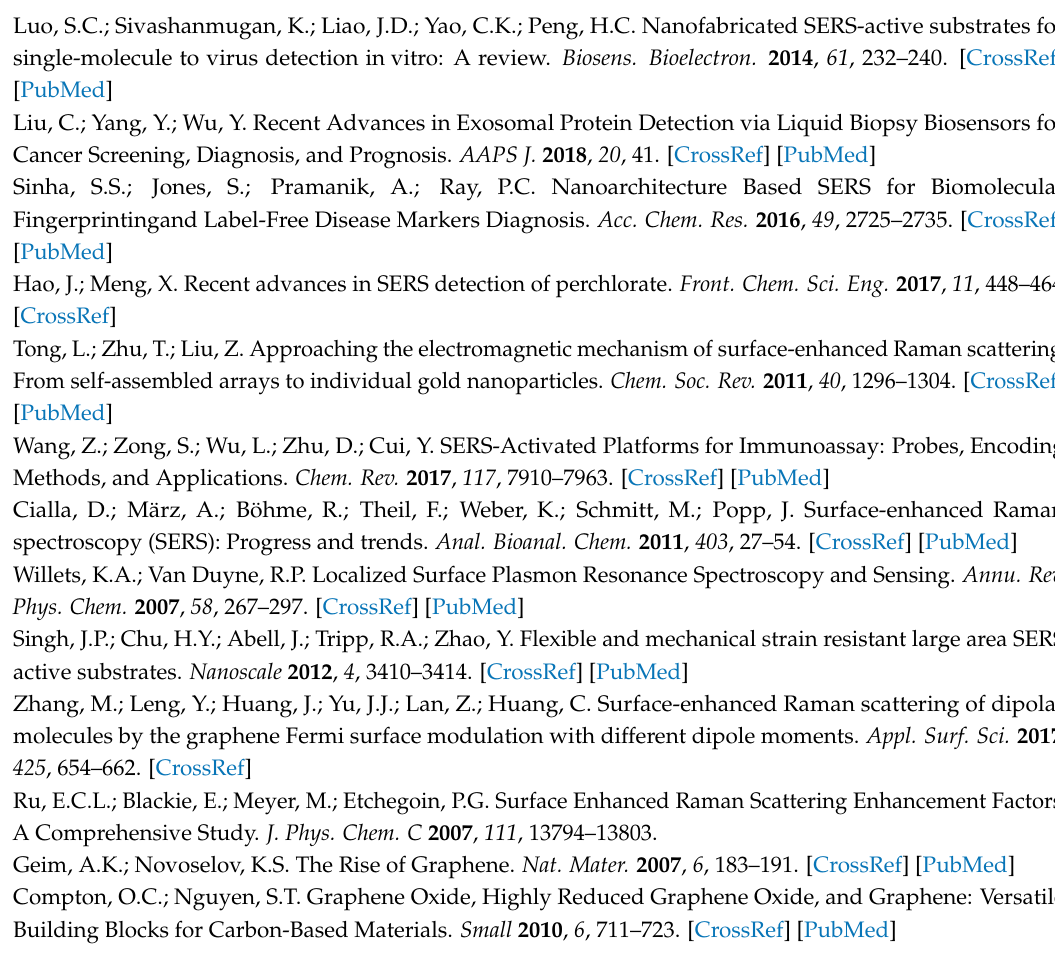
s1, Figure S1: Raman spectra of R6G (10 − 3 M), CV (10 − 3 M), and MG (10 − 3 M) on glass slide substrate, Figure S2: Raman spectra of R6G molecules deposited on GO-LN films by immersing in the solution with different concentrations, Table S1: Sheet resistance of as-prepared samples characterized using four-probe resistance tester, Table S2: Raman peak positions (in cm − 1 ) of R6G, CV and MG on glass slide substrate, and the relative spectral shifts and the enhancement factor (EF) values of R6G, CV and MG on the surfaces of different films. Each Raman spectrum was recorded with an integrated time of 30s, Table S3: The adsorption quantity of R6G on different